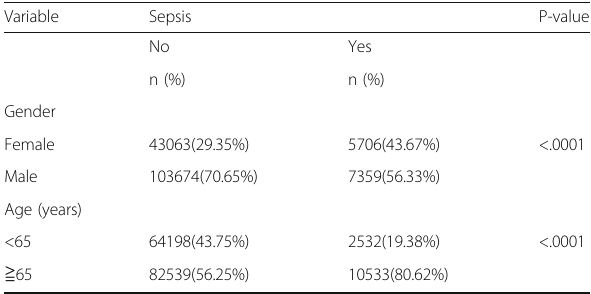
Table 60 (abstract A188). Characteristics in patients with/without sepsis-1